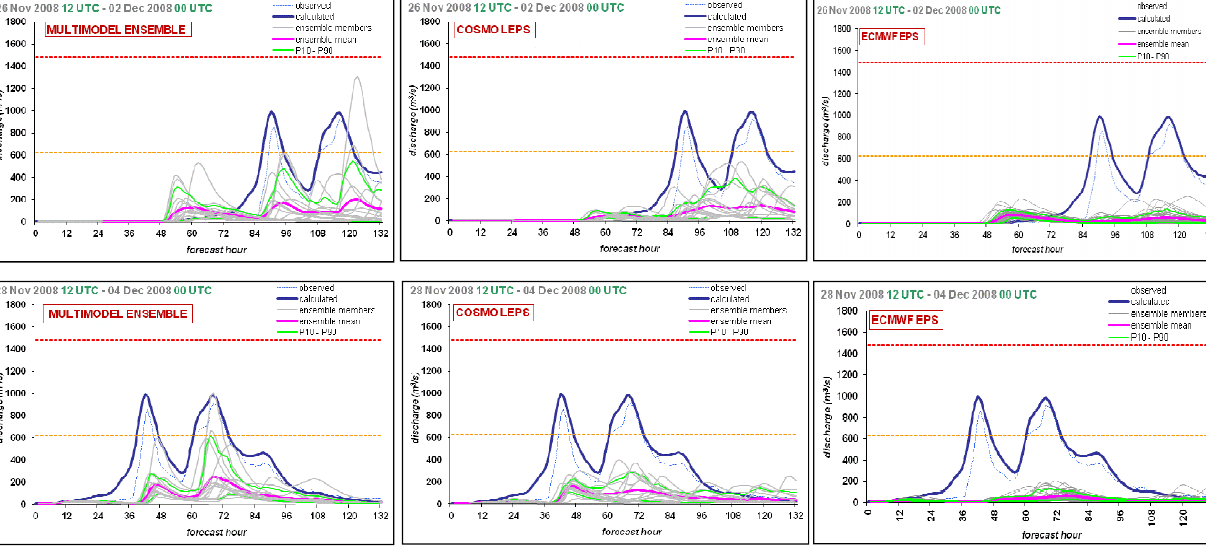
Fig. 6. Discharge forecasts (m 3 s − 1 ) as a function of the forecast range ( h ). The different (grey) curves have been obtained by feeding the TOPKAPI hydrological model with the precipitation forecast by the ensemble members: multi-model (left), COSMO-LEPS (middle) and ECMWF global EPS (right). The rain-gauge-driven (thick blue line) and the observed (blue dashed line) discharges are also plotted for reference. The pink line represents the ensemble mean, while the two green lines represent the 10th and the 90th percentile curves. Top panels refer to forecasts initialized at 12:00UTC, 26 November 2008 (long range in the text); bottom panels to those initialized at 12:00UTC, 28 November 2008 (short range in the text). Orange (red) horizontal line indicates warning (alarm)